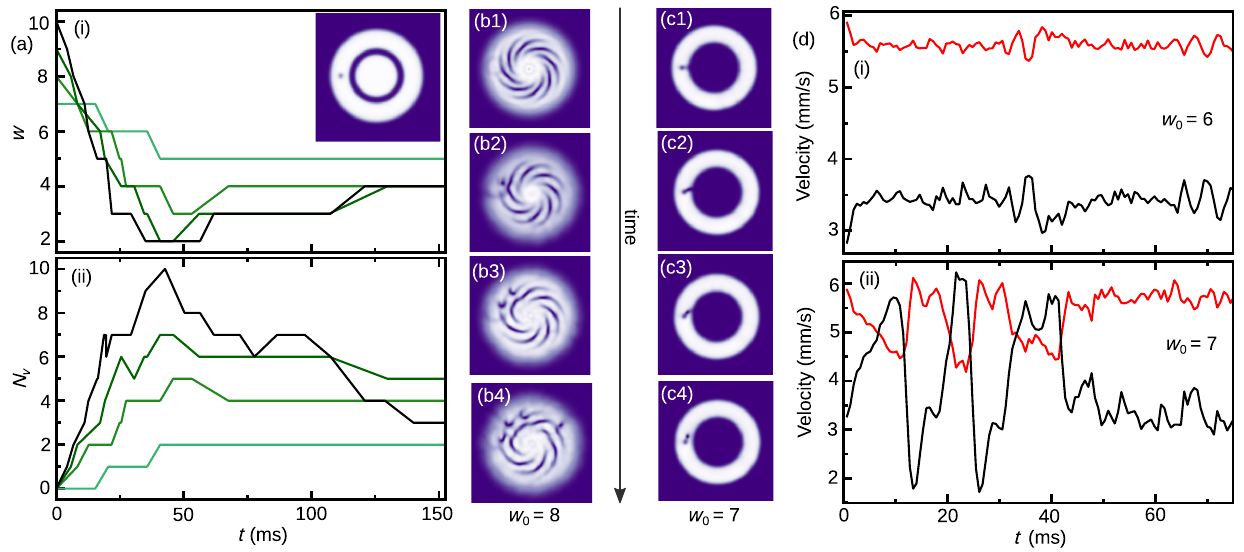
FIG. 9. Numerical study of the current decay in the presence of a local defect. (a) Time evolution of the winding number (i) and of the number of emitted vortices for different circulation states in the range 6 < w 0 ≤ 10 . By employing the confining geometry shown in the inset, we compute the numerical interferograms to extract w and N . Here, the same color convention of Fig. 4 is used. (b1) – (b4) v Numerical interferograms obtained at different times during the vortex emission process for an imprinted circulation w 0 ¼ 8 . The spiral arms give information about the winding number w ; the dots instead indicate the vortices. The interferograms are extracted at t ¼ 0 . 3 ms 0 ), t ¼ 8 . 9 ms (b2: w ¼ 7 , N 1 ), t ¼ 13 . 4 ms (b3: w ¼ 6 , N 2 ), and t ¼ 28 . 0 ms (b4: w ¼ 4 , N 4 ). (c1) – (b1: w ¼ 8 , N v ¼ v ¼ v ¼ v ¼ (c4) The 2D density profiles in the x - y plane of the superfluid with the obstacle, close to the instant the first vortex is emitted for w 0 ¼ 7 , corresponding to (c1) t ¼ 9 . 6 ms, (c2) t ¼ 12 . 7 ms, (c3) t ¼ 13 . 4 ms, and (c4) t ¼ 14 . 0 ms. (d) Time evolution of the local superfluid velocity (black line) and the local speed of sound (red line) extracted at r for the imprinted circulation of (i) w 0 ¼ 6 ¼ w and c (cid:2) (ii) w 0 ¼ 7 . The vertical dashed gray lines for w 0 ¼ 7 indicate the moments the vortices crossed the low-density channel, i.e., (c3) for the first